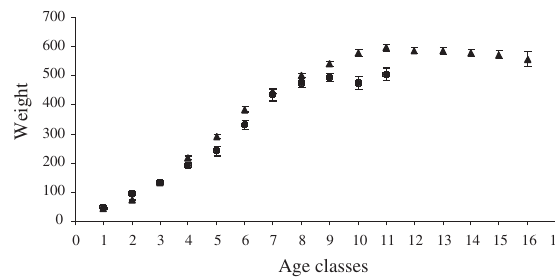
F IG . 1. – Average (± SE) weight gain (g) for each age class of wild reared Audouin’s gull ( Larus audouinii ) chicks, N=106 (solid black dots) and captive reared chicks, N=45 (solid black triangles). Each age class includes periods of three days.